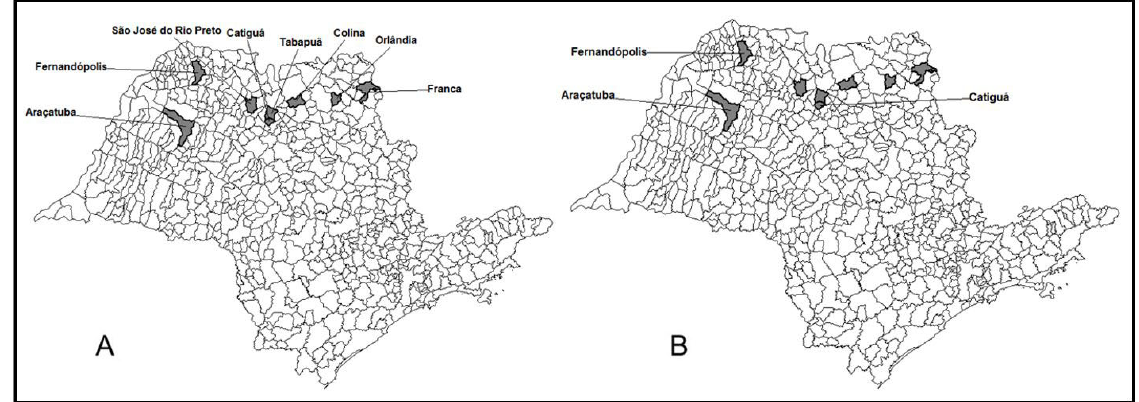
Figure 3. Geographic location of the municipalities of the State of São Paulo, Brazil, where the herds of cut were located (A). Municipalities of the State of São Paulo that had at least one rotavirus positive animal on the PAGE, in herds of cut, from 2006 to 2010